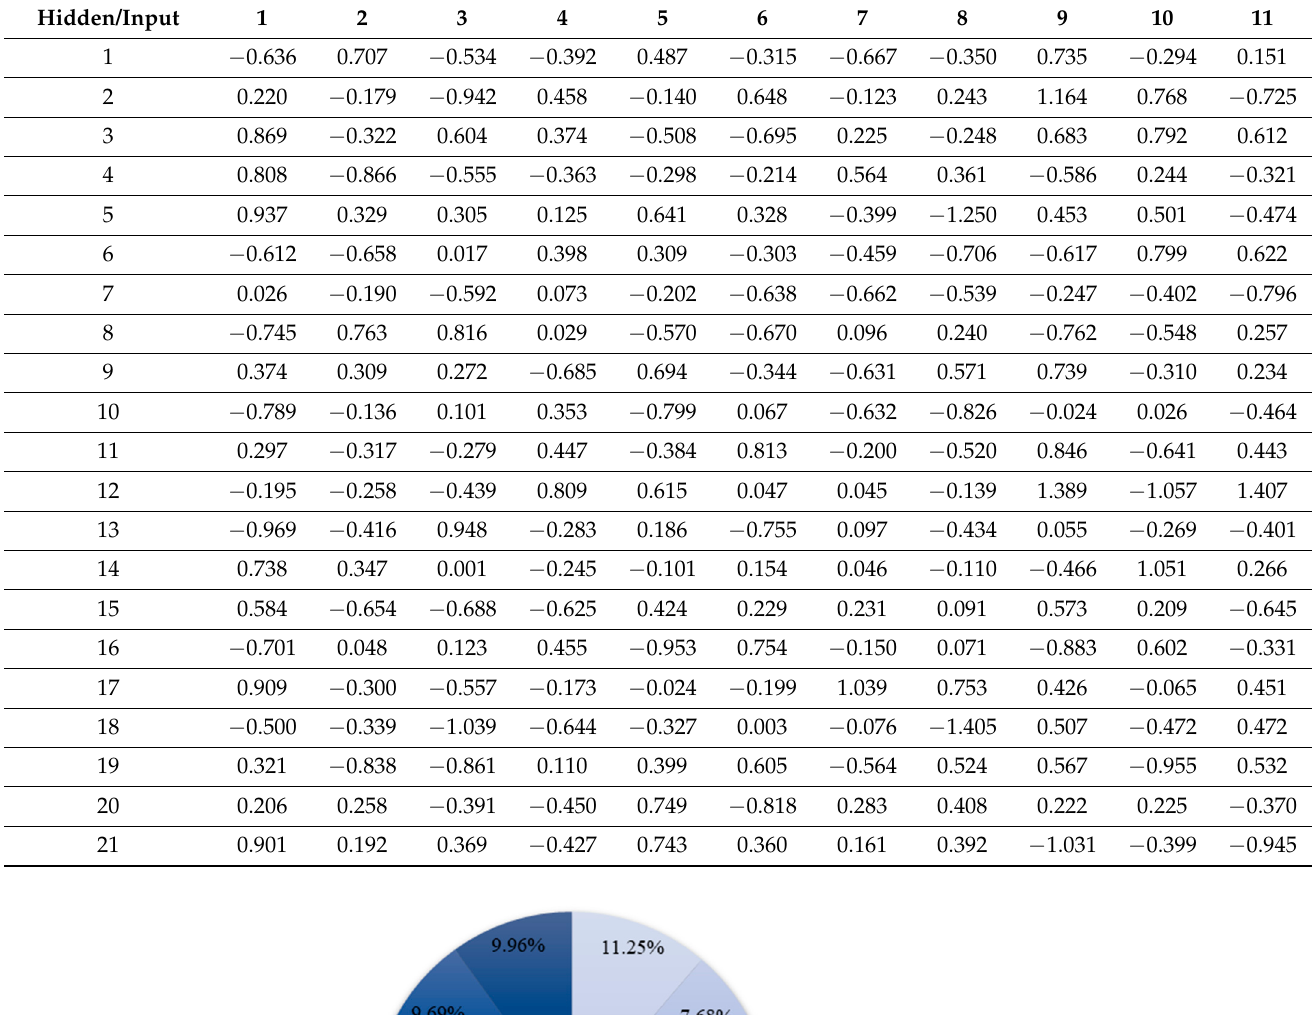
Table 5. Connection weights between the neurons in the input and the hidden layer.